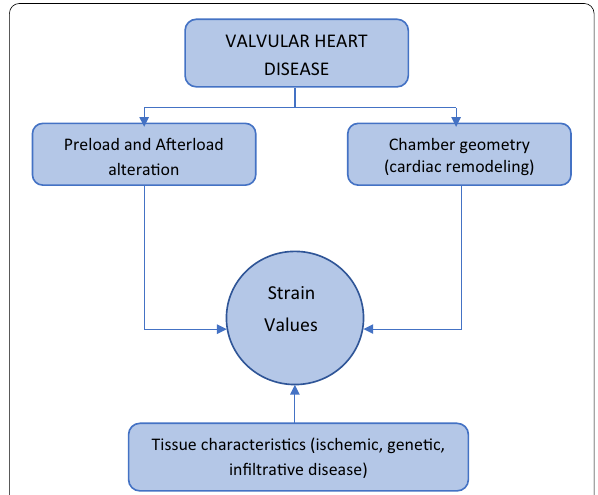
Fig. 1 Several factors influence strain values in